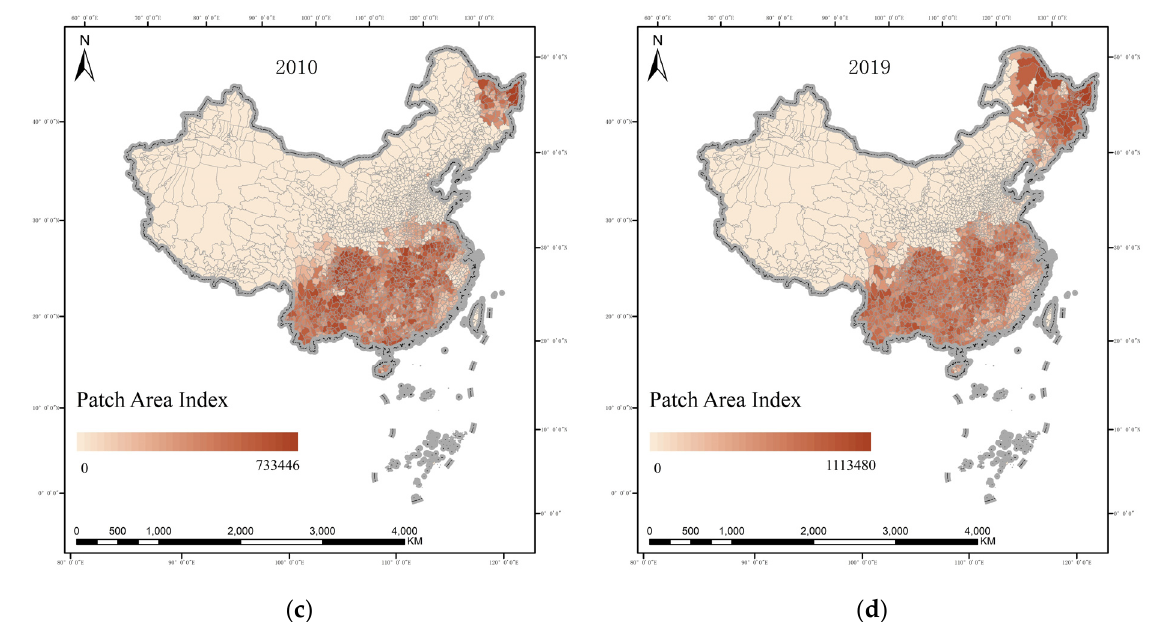
Figure 3. Change in area index of rice production patches in China in ( a ) 1990, ( b ) 2000, ( c ) 2010 and ( d ) 2019.